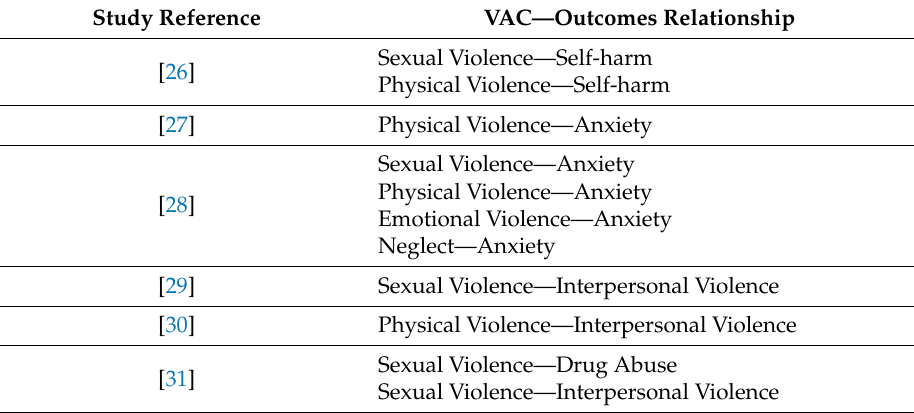
Table A1. Studies used to calculate relative risks (RRs) for violence against children